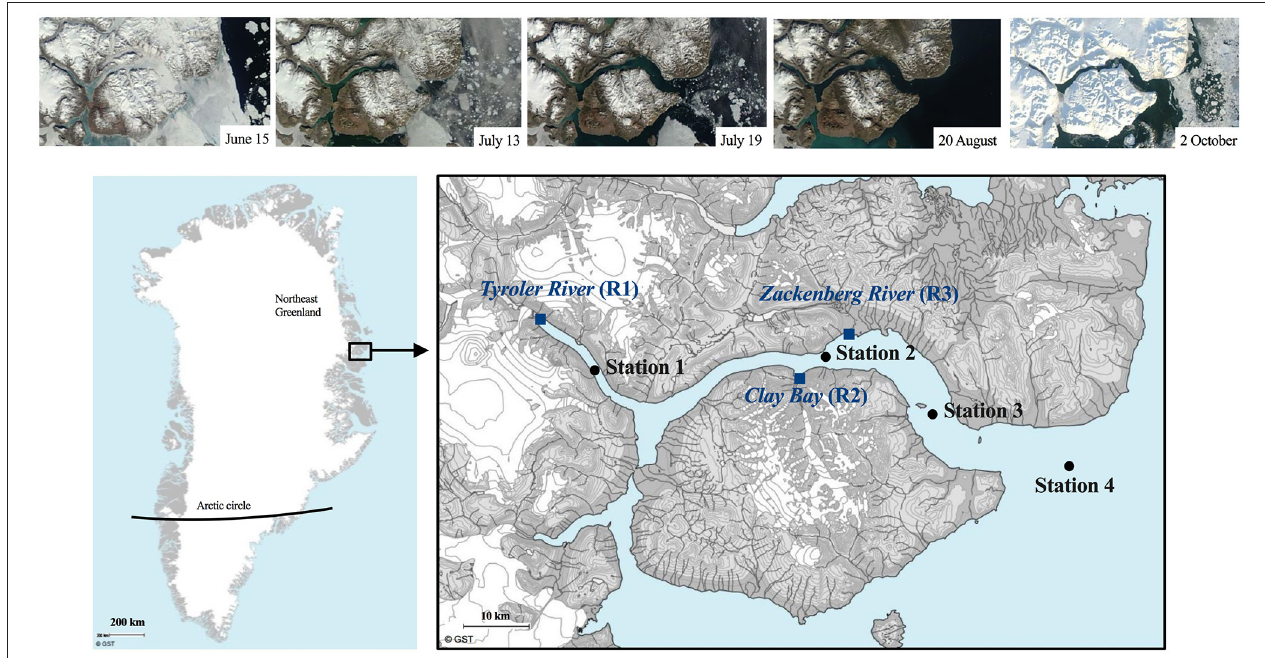
FIGURE 1 | Study area in Northeast Greenland (74 ◦ N, 21 ◦ W) showing the 4 fjord stations (black dots) and the 3 rivers (blue squares). Above are Satellite TERR images from June-August 2014 illustrating the ice and snow conditions as well as the gradient of riverine input (available at